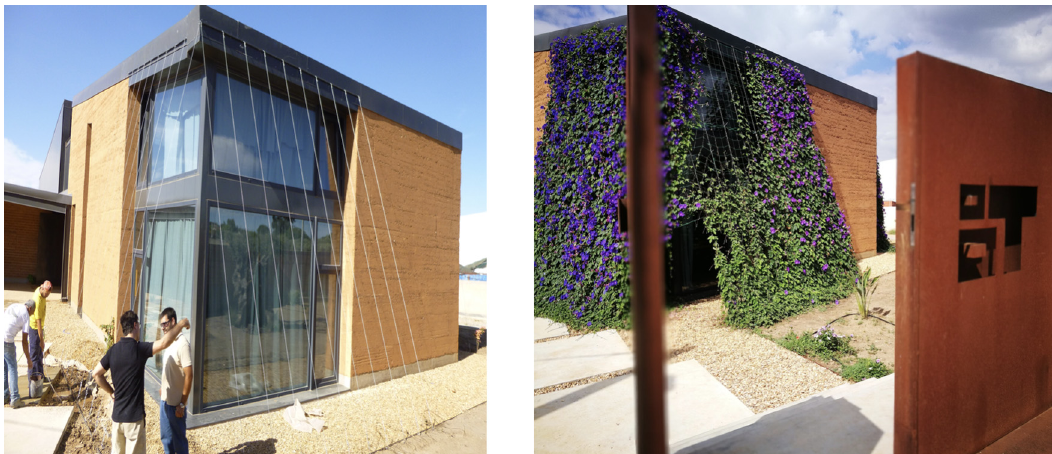
Fig. 7. Serpa architectural of fi ce “ Betão e Taipa ” west glazing exposure. (a) Glazing with the original solar exposure. (b) The same glazing with a natural shading